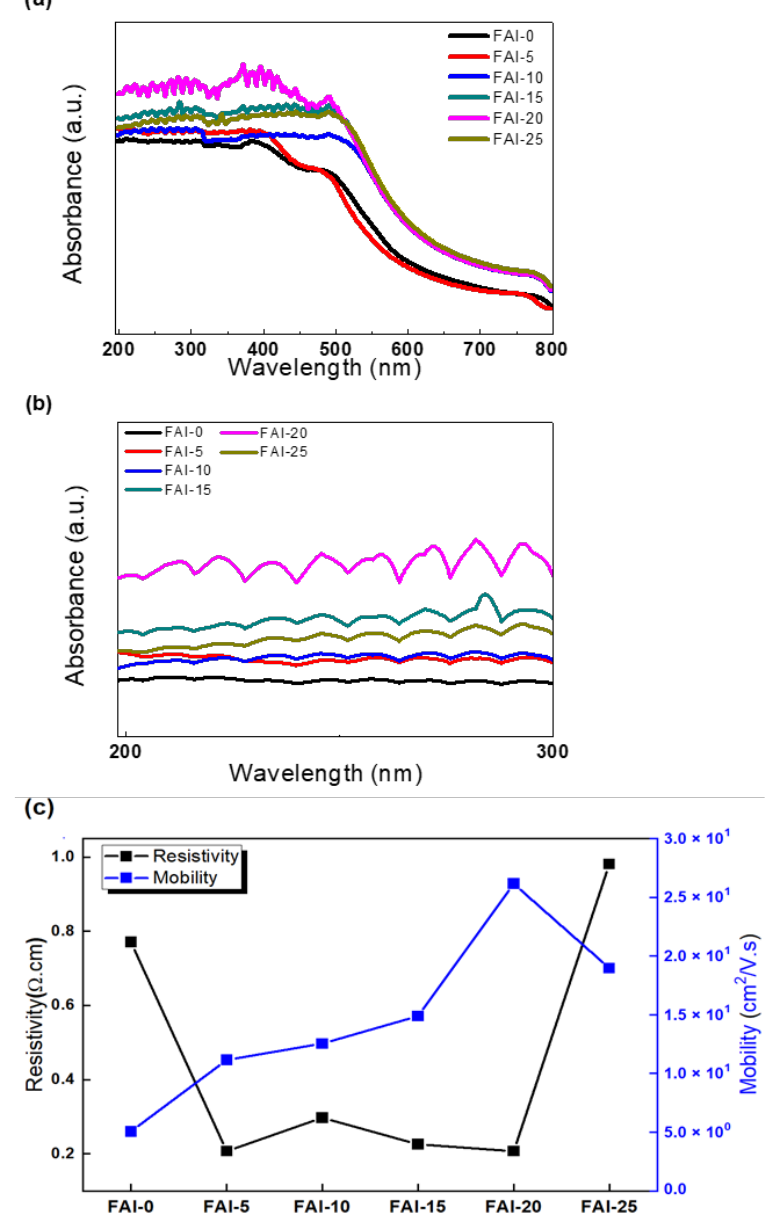
Figure 4. ( a ) UV-Vis absorption spectrum of the prepared FA x MA 1 − x PbI 3 perovskite film. ( b ) An enlarged fingerprint region of the UV-Vis absorption spectrum for the UVC region. ( c ) Photoelectric properties of the FA x MA 1 − x PbI 3 films.